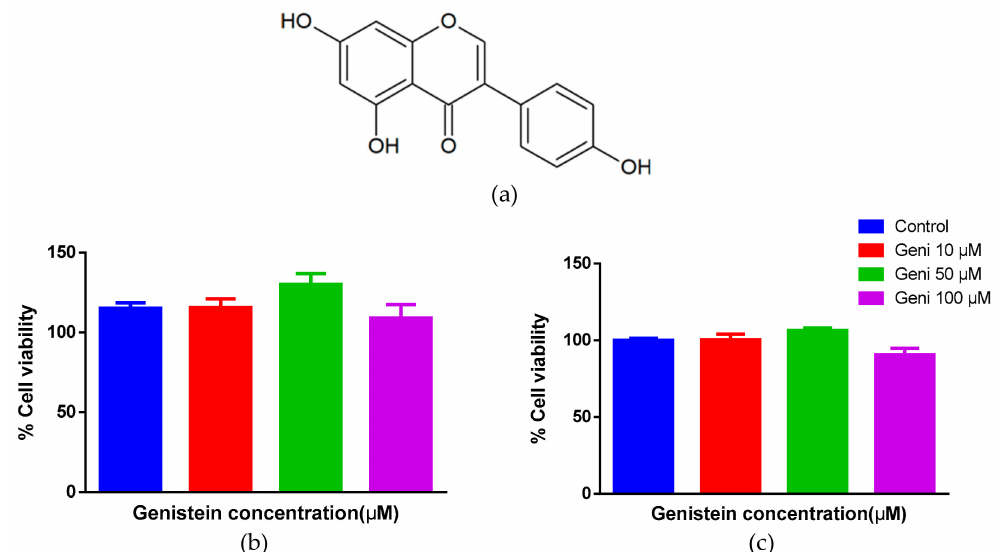
Figure 1. The chemical structure of Genistein ( a ). Cytotoxicity of Genistein on human (LAD-2) mast cells ( b ) and HTLA cells ( c ). Cells (5 × 10 3 cells / well) were pre-treated with Genistein (0–100 µ M) and incubated for 24 h, cell viability was determined by MTT assay. The data are representative of three independent experiments. Each column represents the means ± SEM of three independent